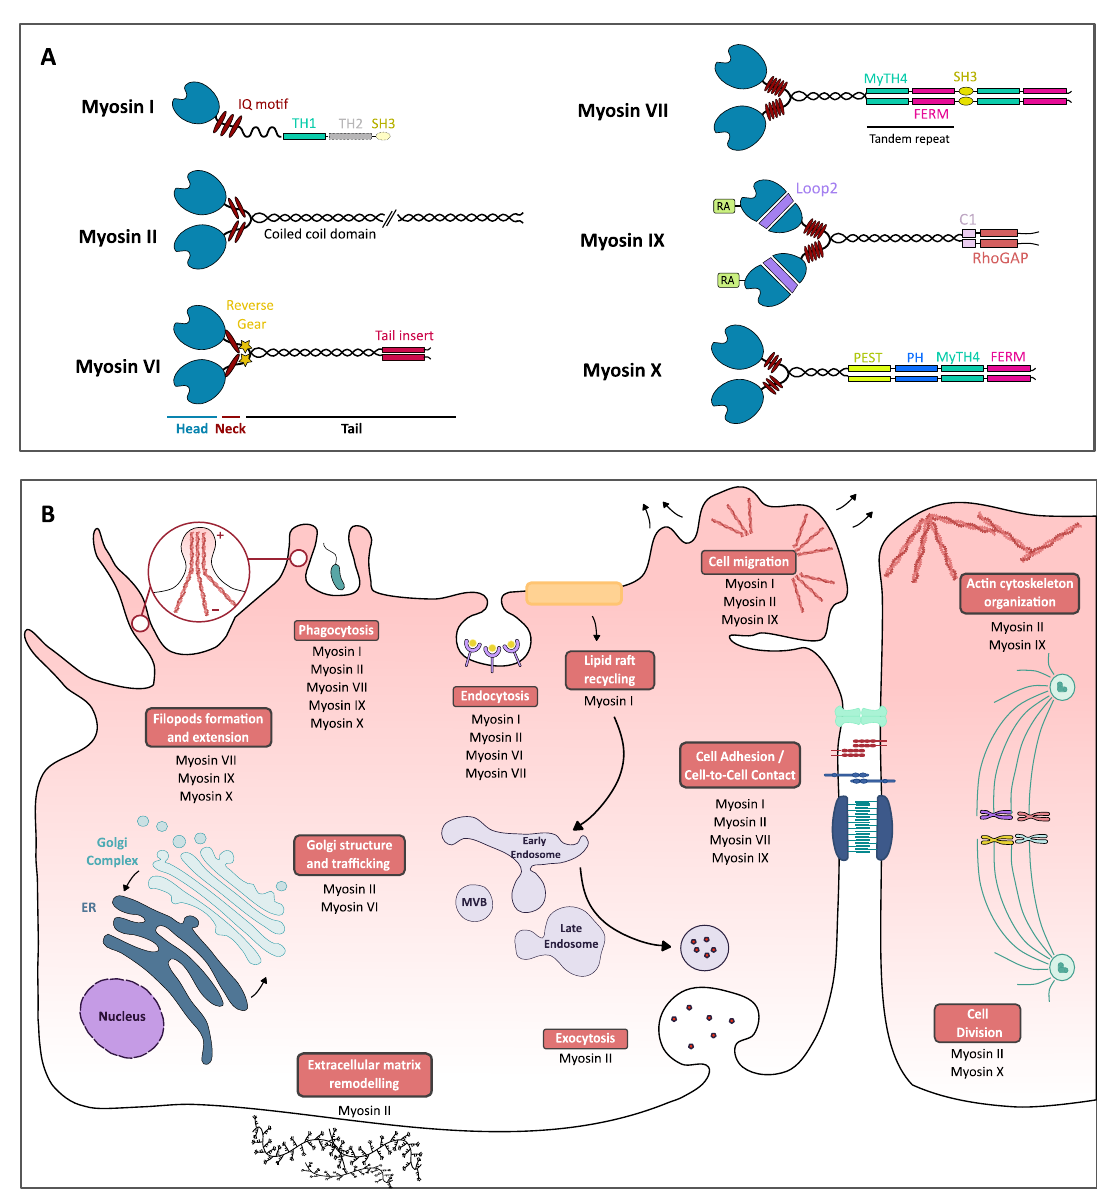
Figure 1. Myosins structure and functions in eukaryotic cells. ( A ) Schematic structure of different classes of myosins. Myosins are all composed of three distinct parts, the head, neck and tail regions. The head (in blue) is the most conserved region as it contains the motor domain as well as the ATP- and actin-binding domain. Class IX myosin head is preceded by a unique extension, an Ras-associated (RA) domain. The neck can vary in the composition in IQ motifs (red ellipses) able to bind different regulating molecules such as the myosin light chains or calmodulin. In the class IV myosin neck region, the stars represent an insertion called the reverse gear that permits the myosin VI to walk in the opposite direction as other myosins. The tail (in black and colored boxes), the most variable domain, is the region where coiled-coil domains can be found, ensuring myosins dimerization, as well as other specific domains that can bind different cargos, which can be related to myosins’ cellular functions: myosin tail homology 4 (MyTH4) domain-binding cytoskeletal proteins such as microtubules, four-point-one, ezrin, radixin, moesin (FERM) domain, mostly found in cytoskeletal-associated proteins, that allows proteins to bind membrane proteins, SH3 (Src homology 3) domain-binding to adaptor proteins or phosphorylated tyrosine residues, C1 or phorbol esters/diacylglycerol-binding domain, Rho GAP-domain-binding Rho GTPases, PEST region found on proteins with short half-life and Pleckstrin homology (PH) domain, allows proteins to bind to phosphoinositids and therefore to the plasma membrane [1]. Class I myosins can present short-tail (continuous line) or long-tail isoforms (discontinuous line) thanks to supplementary domains. ( B ) Schematic representation of cellular processes (boxed in red) and the associated myosins. This representation is not exhaustive of all the roles of